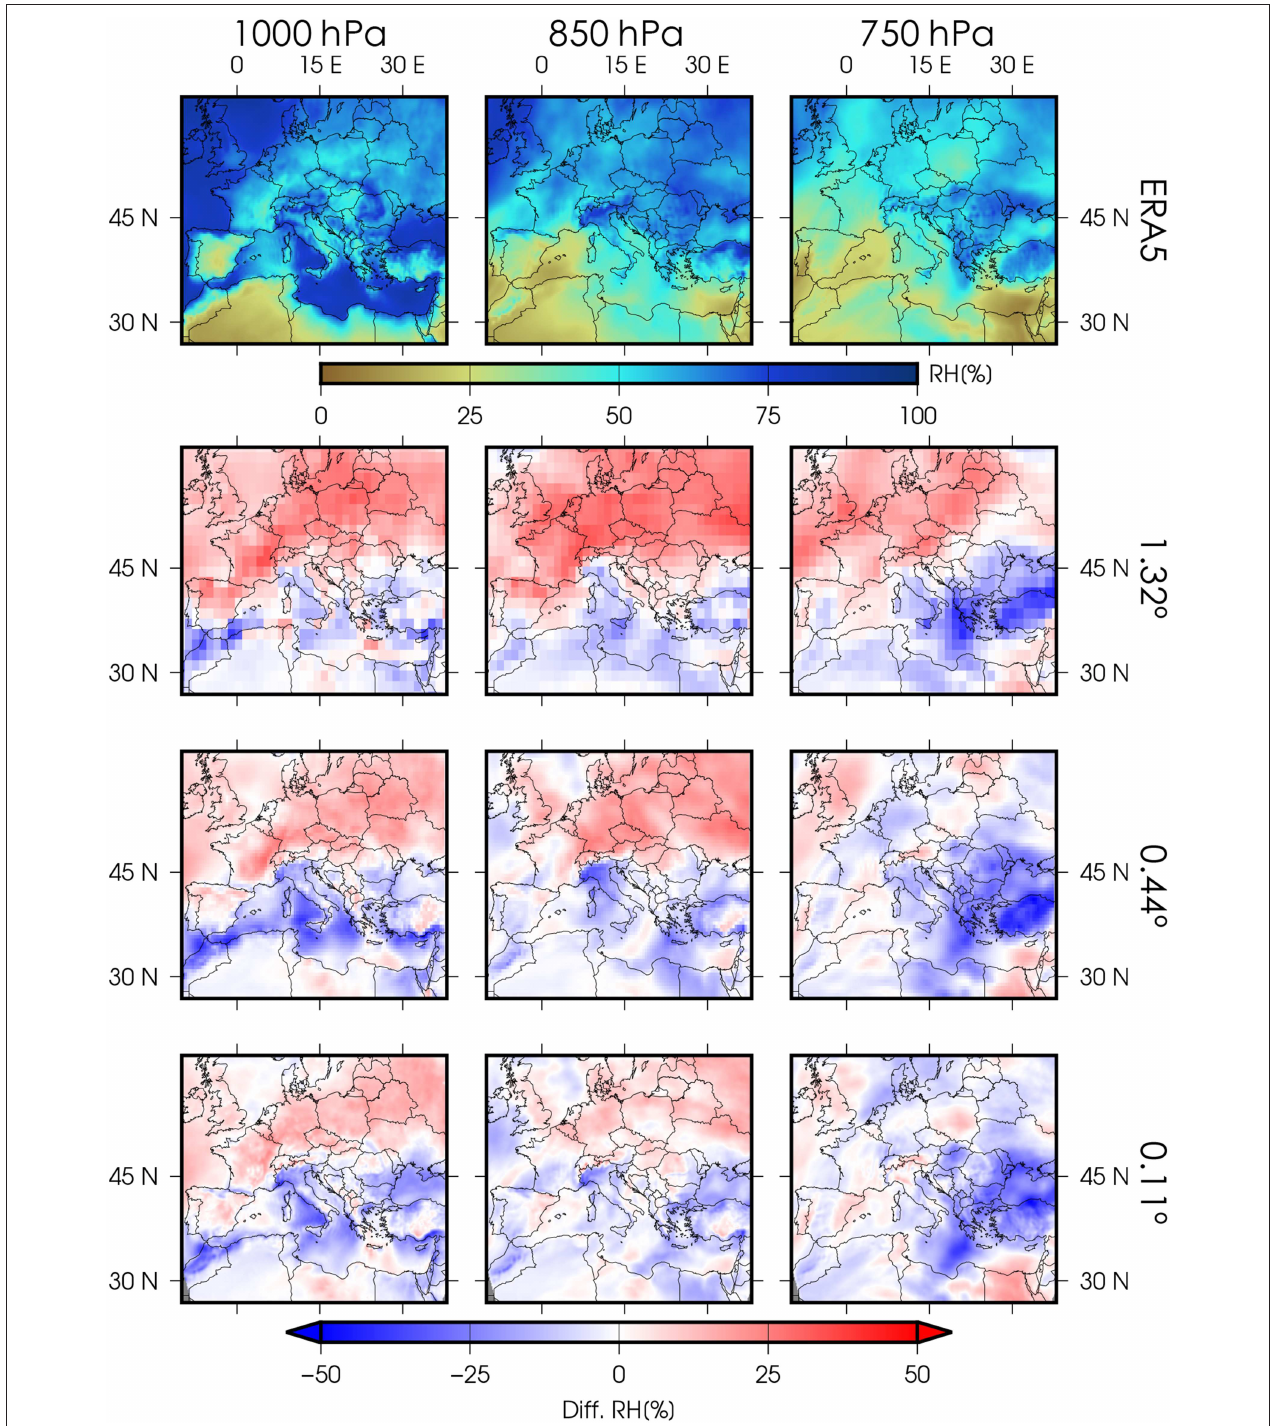
FIGURE 7 | ERA5 relative humidity (RH) at 1000 hPa (left column), 850 hPa (middle column), and 750 hPa (right column) and the differences with each simulation at: second row, 1.32 ◦ ; third, 0.44 ◦ ; and fourth, 0.11 ◦ .